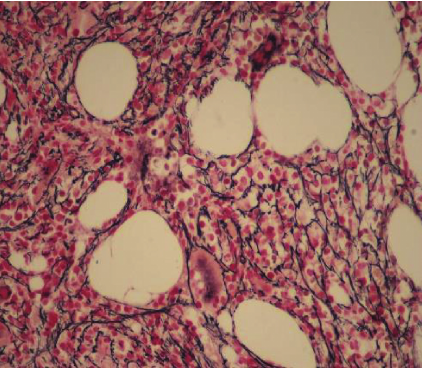
Figure 2: Reticulin stain of the bone marrow biopsy showing increased